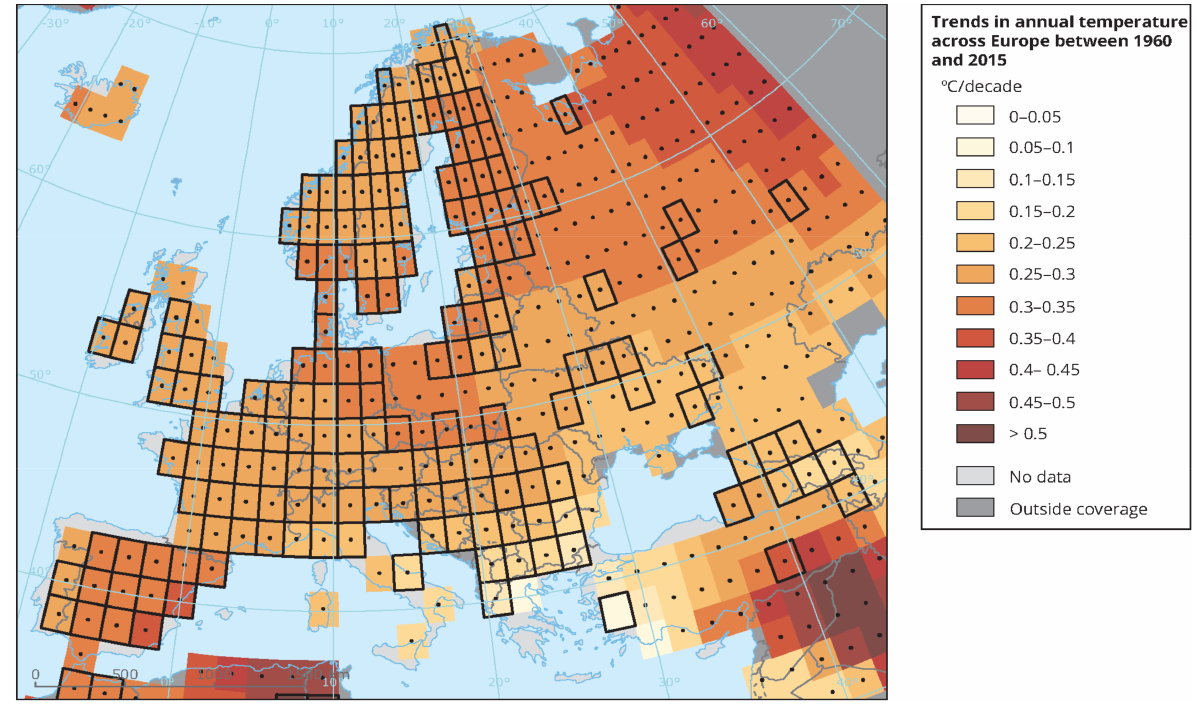
Figure 1. Observed trends in number of warm days during the period 1971-2000.